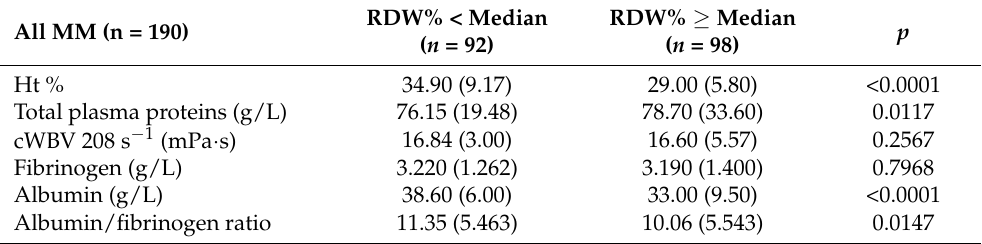
Table 7. Medians (IQR) of hemorheological determinants in all MM patients subdivided according to the median of RDW%.